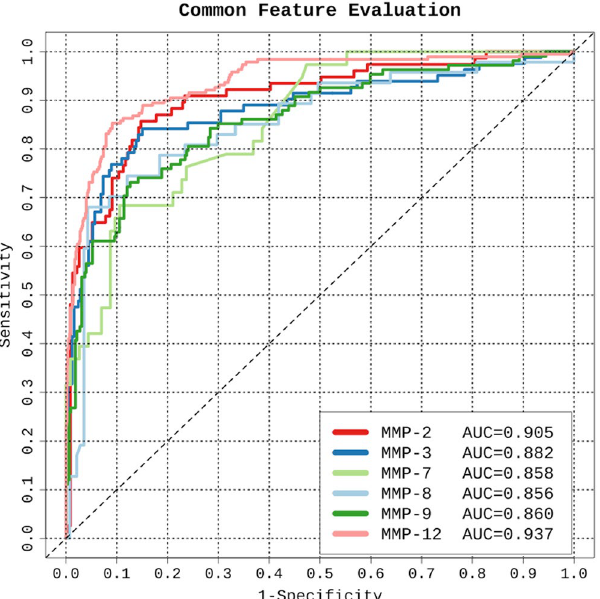
Figure 3. Performance of SVR models trained using the extracted common knowledge of MMPs in the source domain for the substrate cleavage site prediction of a corresponding MMP in the target